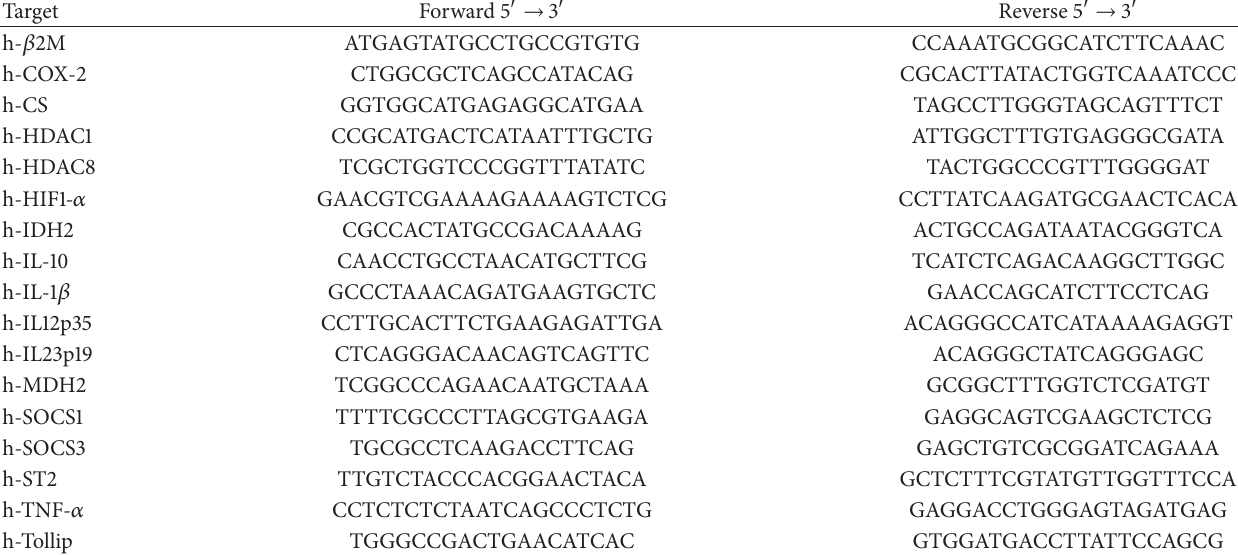
Table 1: Primer sequences used for gene expression measurements by